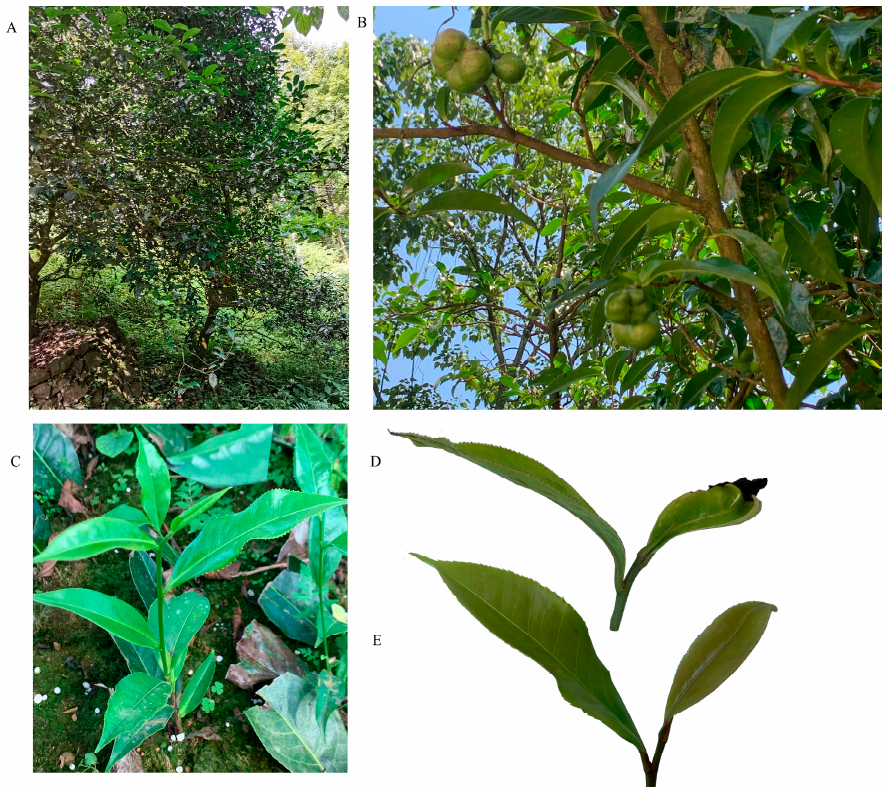
Figure 1. The tea tree ( C. tetracocca ) was attacked by E. onukii. ( A ) C. tetracocca grown in the field habitat. ( B ) Tea seeds of C. tetracocca . ( C ) The sprout of C. tetracocca grown in the field habitat. ( D ) The leaves of C. tetracocca attacked by E. onukii . ( E ) The healthy leaves of C. tetracocca .